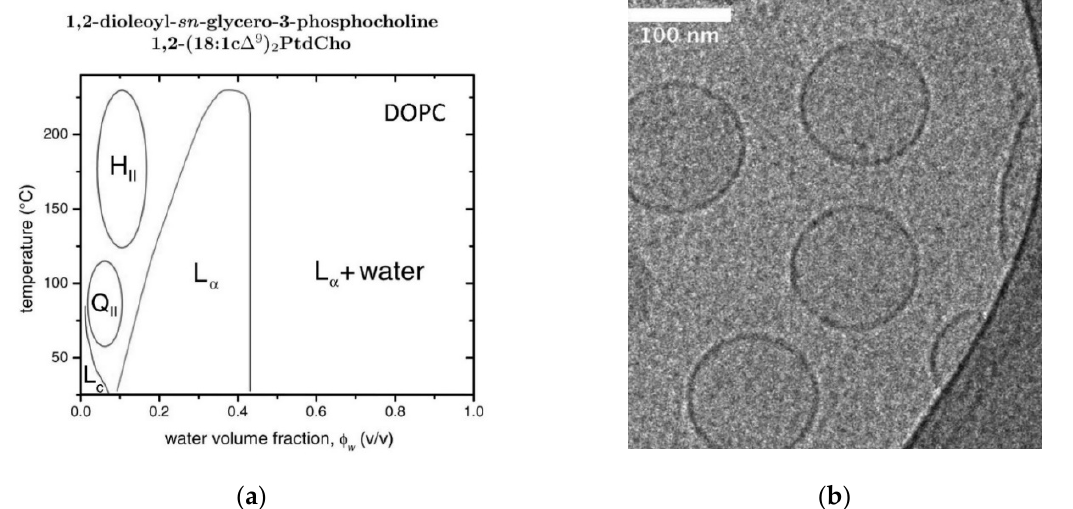
Figure 10. Aqueous dispersions of DOPC. ( a ) Binary DOPC/water phase diagram, published by Marsh (2013) [84], drawn on the basis of the phase diagram elaborated by Bergenståhl and Stenius (1987) [90]. L α , lamellar phase; L α + water, two coexisting phases; Lc, lamellar crystals; Q II , inverse cubic phase, H II , inverse hexagonal phase. ( b ) Example of a cryo-TEM image of a dispersion of unilamellar DOPC vesicles (0.1 wt% in water (=1.3 mM; bar: 100 nm), prepared with the polycarbonate membrane extrusion method (see Chapter 4), using for the final extrusions 100 nm pore membranes; see Hoffmann et al. (2014) [91]. Reproduced from [84], copyright © Taylor and Francis, 2013; and with permission from [91], Royal Society of Chemistry,